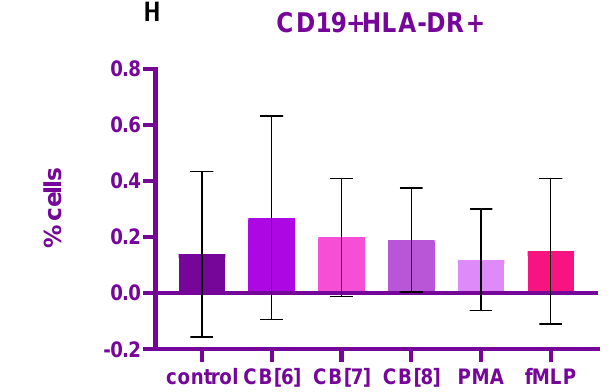
Figure 3. Graph of the percentage of cells of various subpopulations of lymphocytes, producing reactive oxygen species ( A – H ) in response to 24-h stimulation with cucurbiturils (CB [6,7,8]). Data are presented as median ± interquartile range with n = 10. * p < 0.05 for comparing CB[6] group with control and PMA by employing one-way ANOVA, Friedman